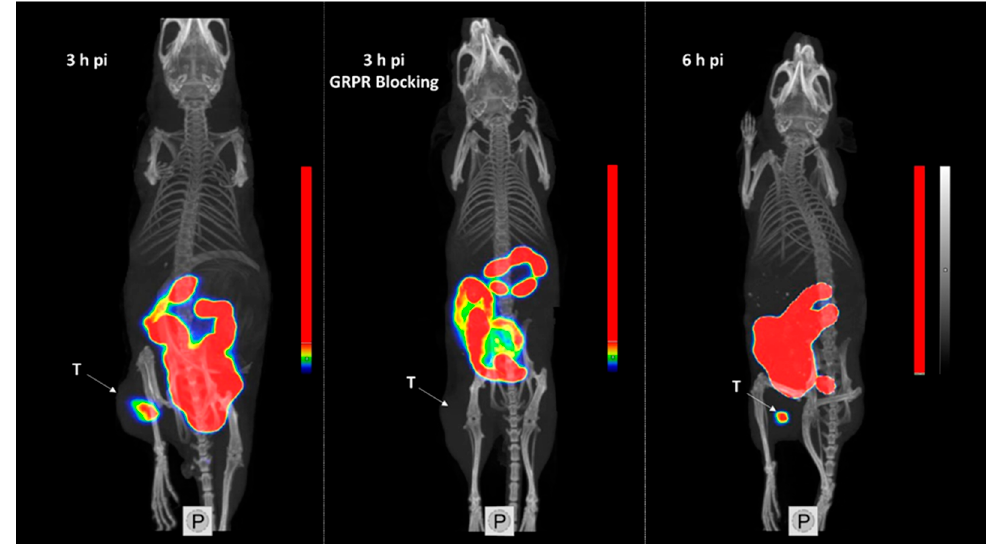
Figure 8. Single-photon emission computed tomography/computed tomography (SPECT/CT) images of BALB/C nu/nu mice bearing PC-3 xenografts (denoted by a letter T) injected with [ 99m Tc]Tc-maSSS-PEG 2 -RM26 at 3 and 6 h pi, or with [ 99m Tc]Tc-maSSS-PEG 2 -RM26 in addition to 5 nmol of maSSS-PEG 2 -RM26 to block GRPR.